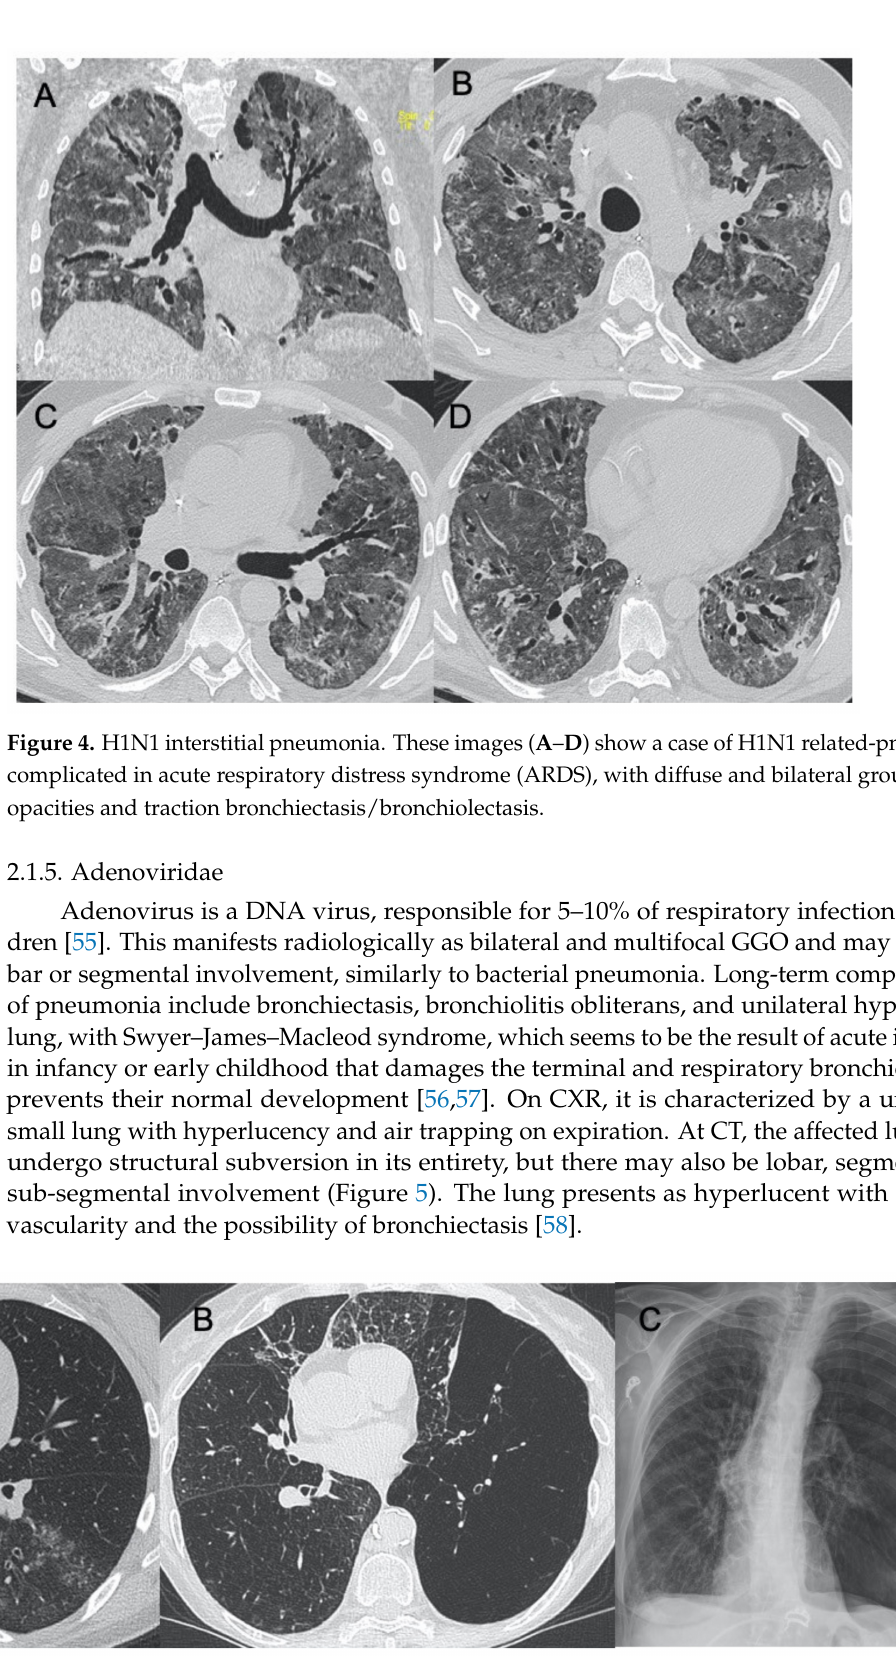
Figure 5. Adenovirus pneumonia and Swyer–James syndrome. Figure in ( A ) shows a case of acute adenovirus pneumonia, with typical multifocal and lobar ground-glass opacities, similar to bacterial pneumonia. Images in ( B , C ) show a case of long-term complication, a unilateral hyperlucent lung (Swyer–James–MacLeod